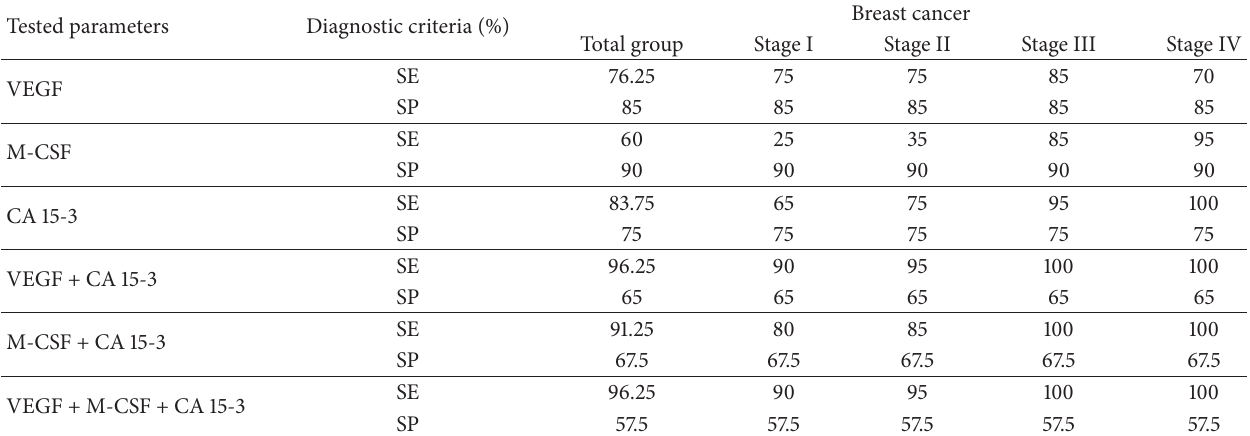
Table 2: Diagnostic criteria of tested parameters and in combined analysis with CA 15-3 in breast cancer patients. Tested